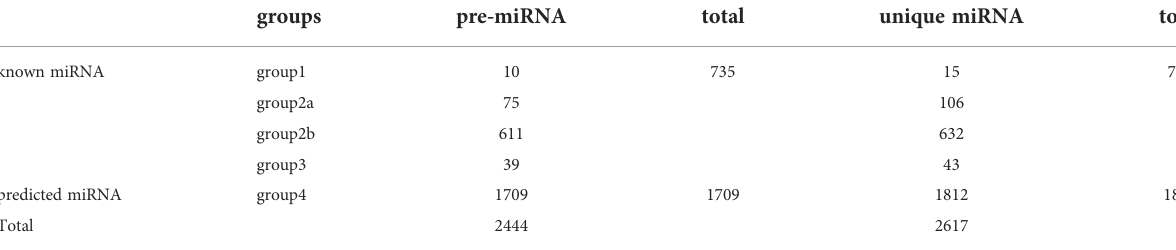
TABLE 2 Summary of known and predicted